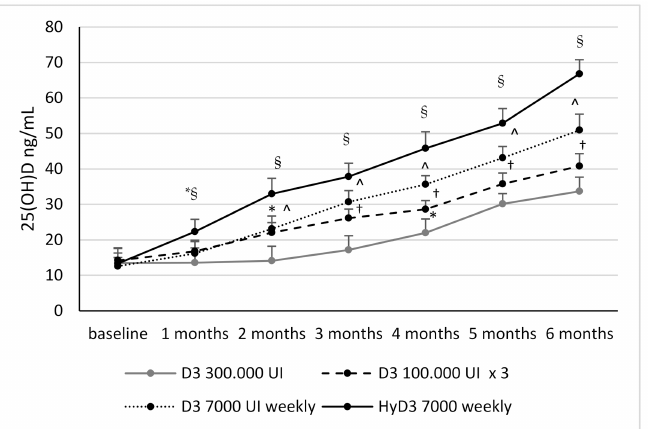
Figure 2. 25(OH) Vitamin D serum levels. *: p < 0.01 vs. baseline; §: p < 0.01 vs. Group 1, 2, 3;